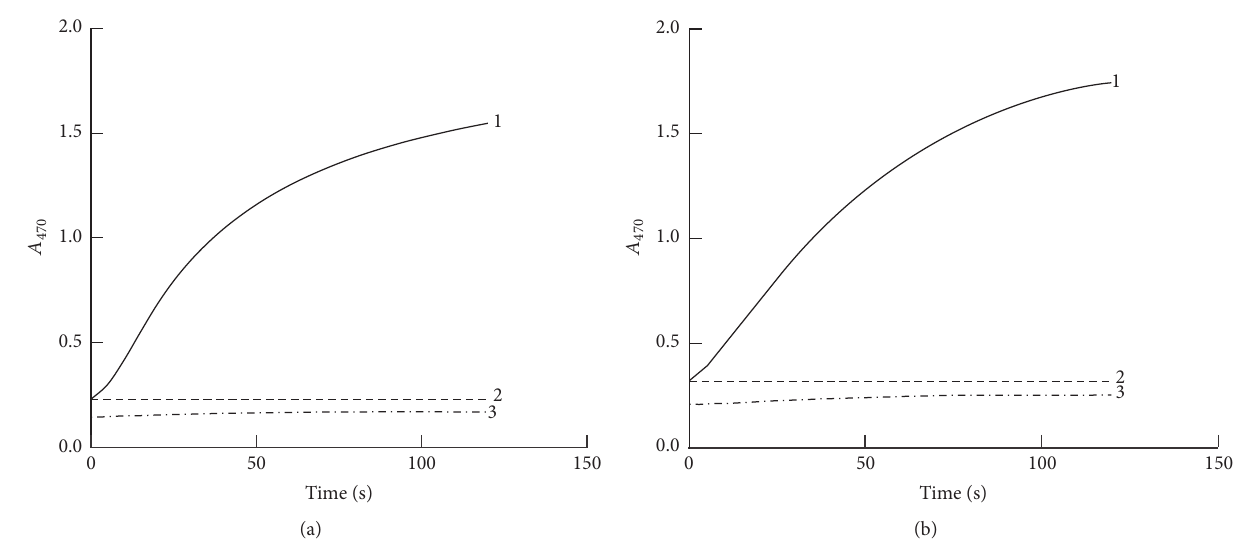
Figure 1: The peroxidase activity of Tg-Hb. (a) Tg-HbI, (b) Tg-HbII; 1: Tg-Hb + guaiacol + H 2 O 2 , 2: Tg-Hb + H 2 O 2 , and 3: Tg-Hb + guaiacol.